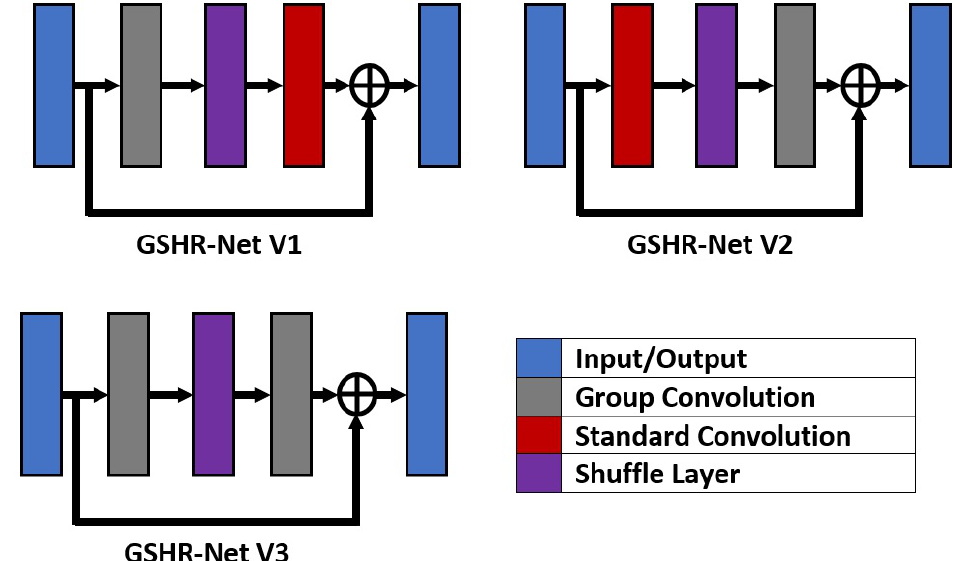
Figure 5. Three variants of group and shuffle operators network